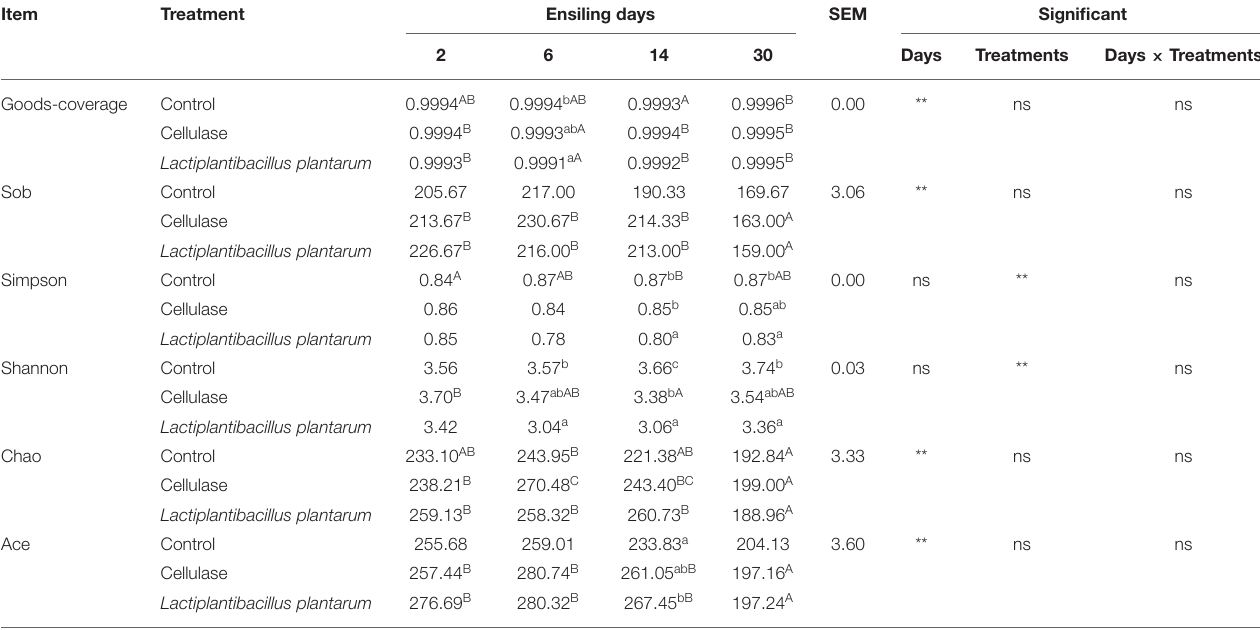
TABLE 5 | Alpha diversity of the bacterial community of ensiled Cassia alata .